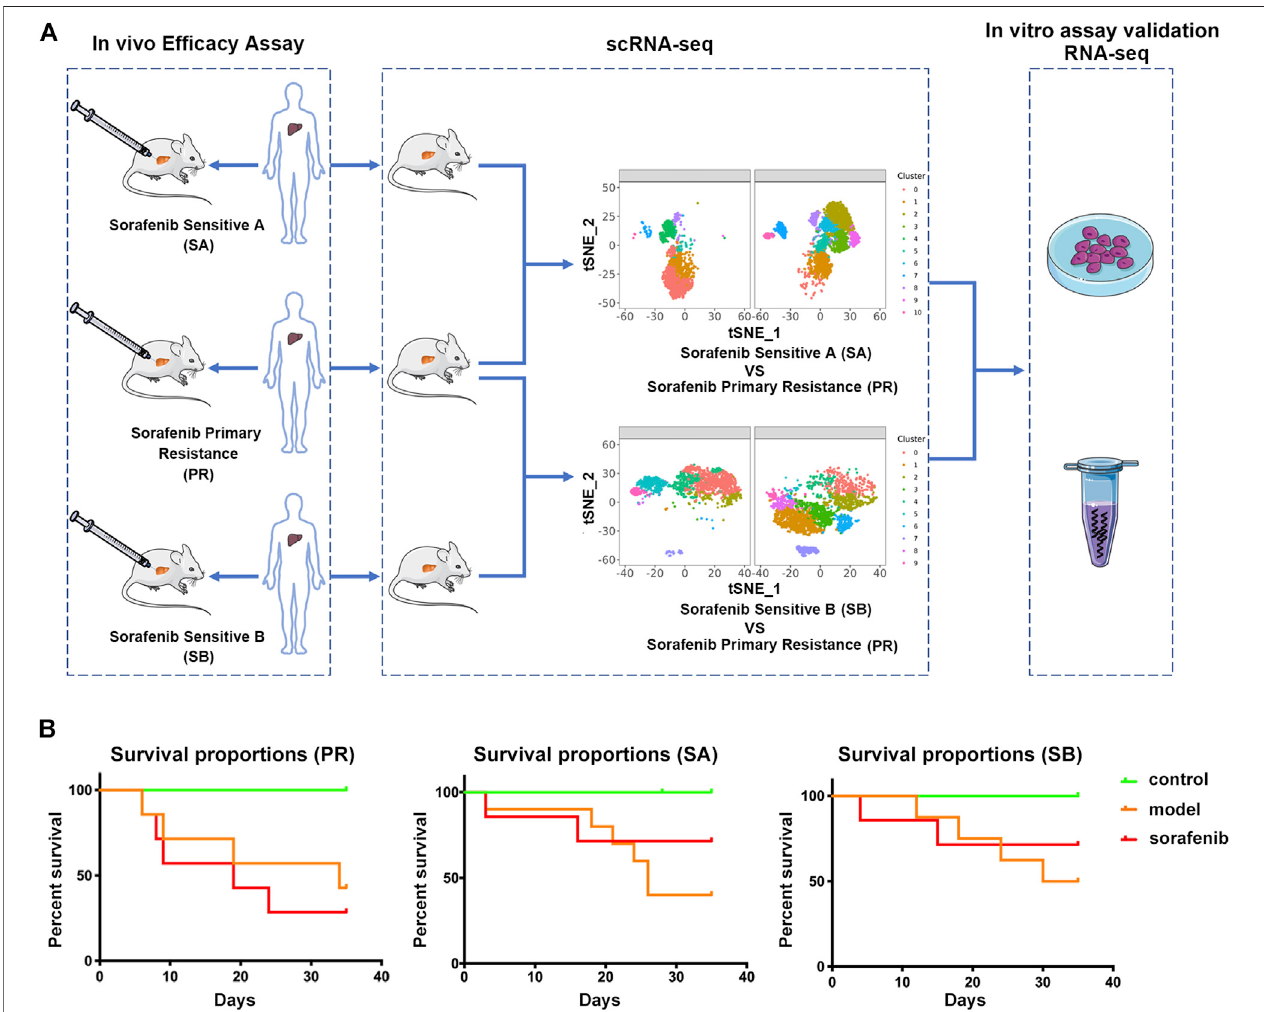
FIGURE 1 | Characterizing sorafenib primary resistance cell in HCC by Single-Cell RNA-Seq. (A) Work fl ow of the sample preparation, sequencing and bioinformatic analysis (B) Statistics of survival rate ofthree groups of PDX model mice. Tumor tissuesof three HCC patientswere grown as orthotopic xenografts. In the controlgroup,NCG mice weretreatedwithsalineintravenously(i.v.);inthemodelgroup, PDX modelmice weretreatedwithsalineintravenously(i.v.).Above twogroups wereinjectedoncedaily (qd) for35 days.Inthesorafenibgroup, PDX modelmice weretreatedwith50 mg/kg viaoralgavage,oncedailyfor35 days.AllPDX mice were sacri fi ced on the 35th